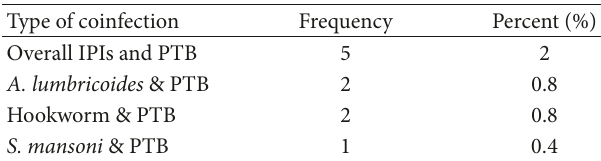
Table 3: Prevalence of coinfection of intestinal parasites and PTB among PTB suspected patients at University of Gondar Hospital, Ethiopia,